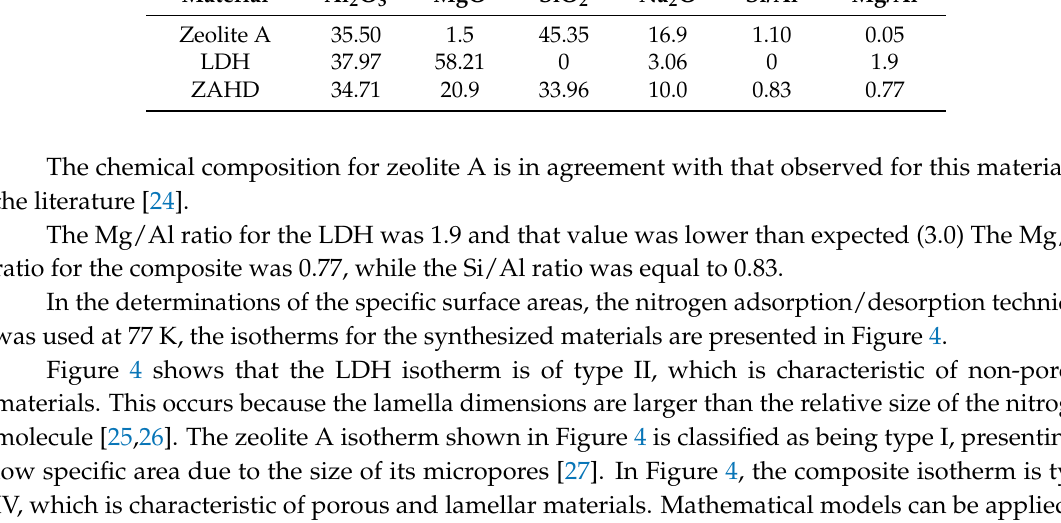
Table 1. FRX results in % for the synthesized materials.